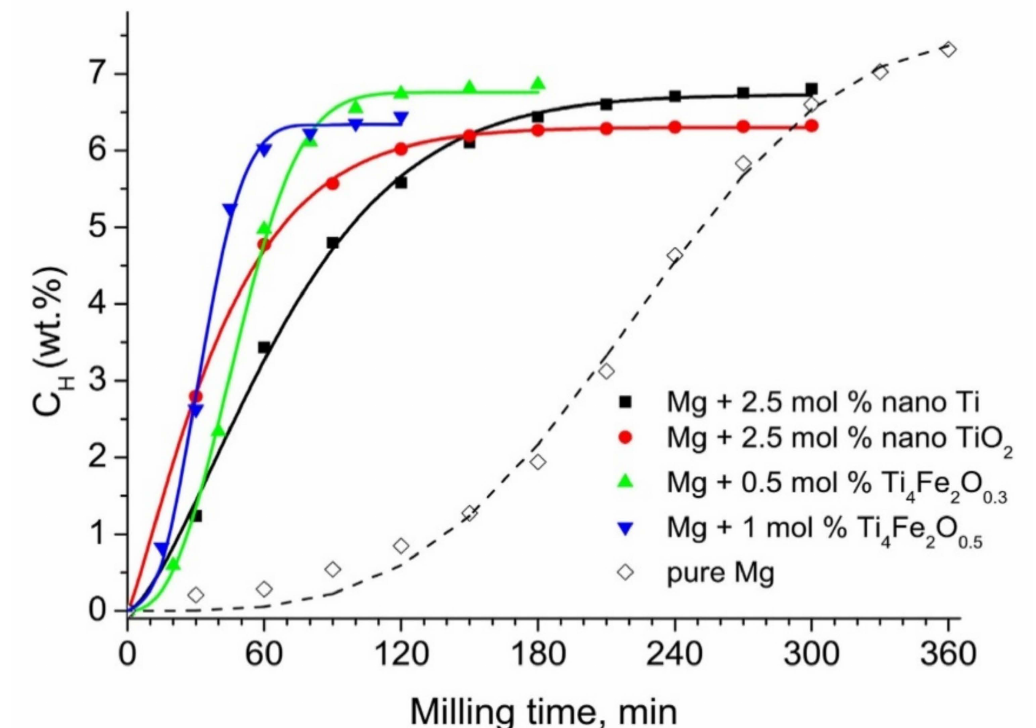
Figure 17. Hydrogen absorption by powder mixtures of Mg with Ti-based additives during reactive ball milling in hydrogen [119]. (Reprinted with permission from Elsevier).